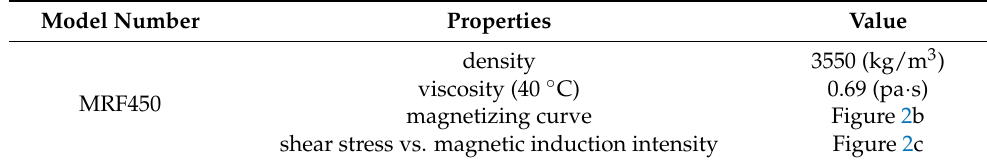
Figure 2. MRF450: ( a ) description of MRF; ( b ) magnetization curve; and ( c ) the shear stress vs. magnetic induction intensity. Table 1. MR fluid properties.